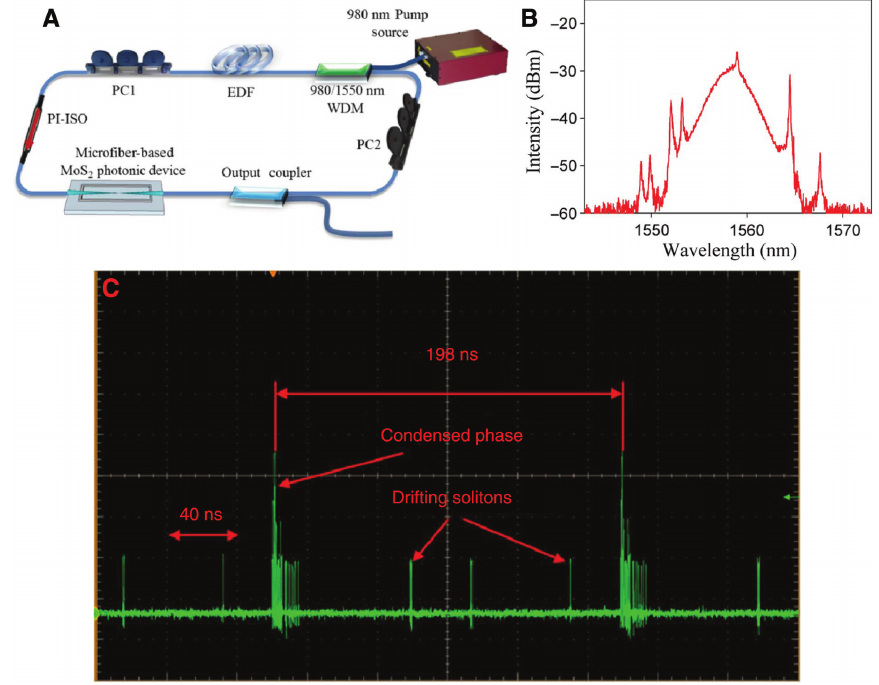
-deposited microfiber SA. 2